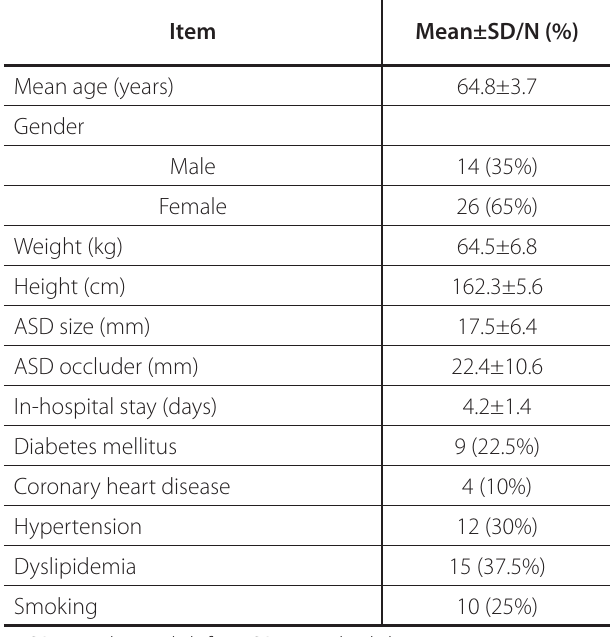
Table 1 . Sociodemographic characteristics of the